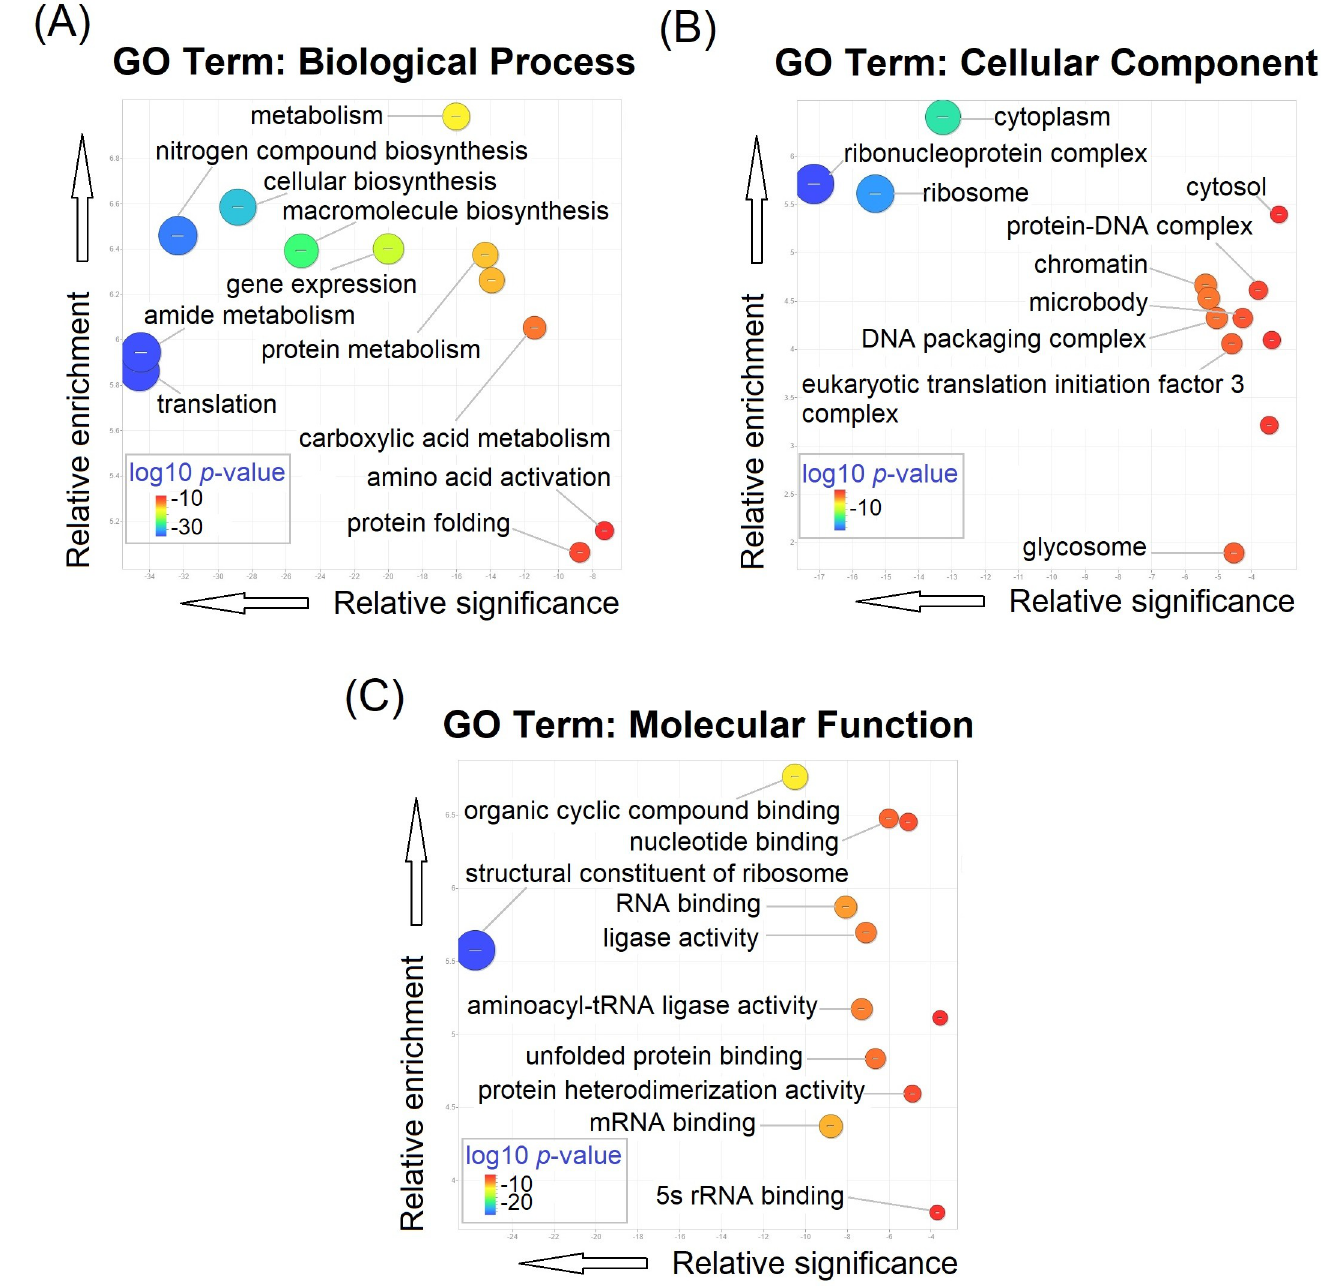
Fig 7. Gene Ontology Term enrichment of the 299 starvation-specific NSPs at 2 hours of starvation relative to the predicted L . mexicana whole proteome. ( A ) GO term enrichment for Biological Process ( B ) GO term enrichment for Cellular Component, and ( C ) GO term enrichment for Molecular Function. The GO terms were refined and visualised using REVIGO